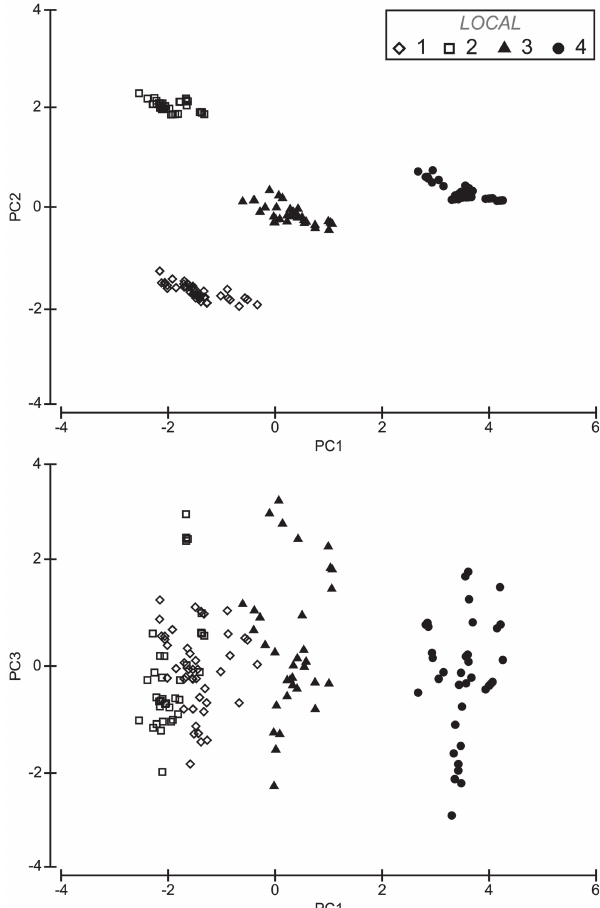
Fig. 2 . Ordination Diagram for principal components analysis on environmental parameters (A= PC1 vs. PC2; B= PC1 vs. PC3), coded by site from rio Mamanguape estuary. Sites: Mud flat (Diamond); Tidal Creek 1 (Square); Tidal Creek 2 (Black triangle); Tidal Creek 3 (Black